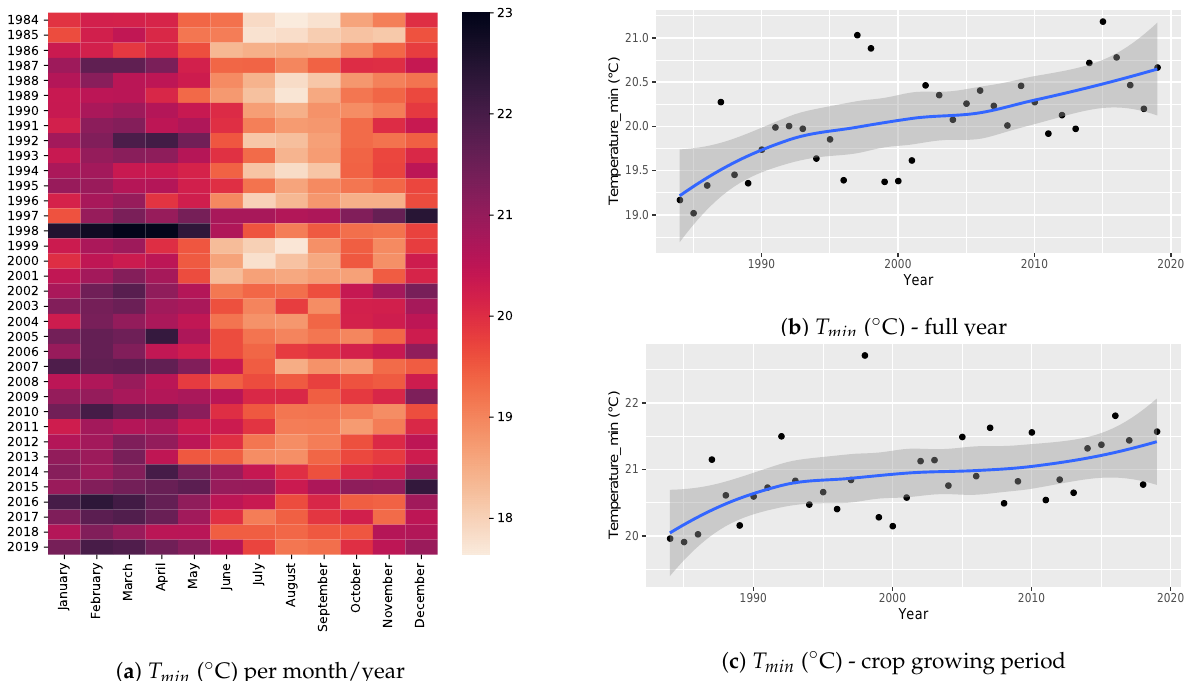
Figure 2. Time series of average minimum temperature ( ◦ C) in Guayas from 1984 to 2019. ( a ) Heat-map of T min ( ◦ C) per each month and year. The color scale represents the temperature in ◦ C. ( b ) T min ( ◦ C) averaged during the full year. ( c ) T min ( ◦ C) averaged during the maize crop growing period in Ecuador (January–May). Each dot represents one record, the blue line shows the smoothed time series and the shaded area represents the 95% confidence interval.